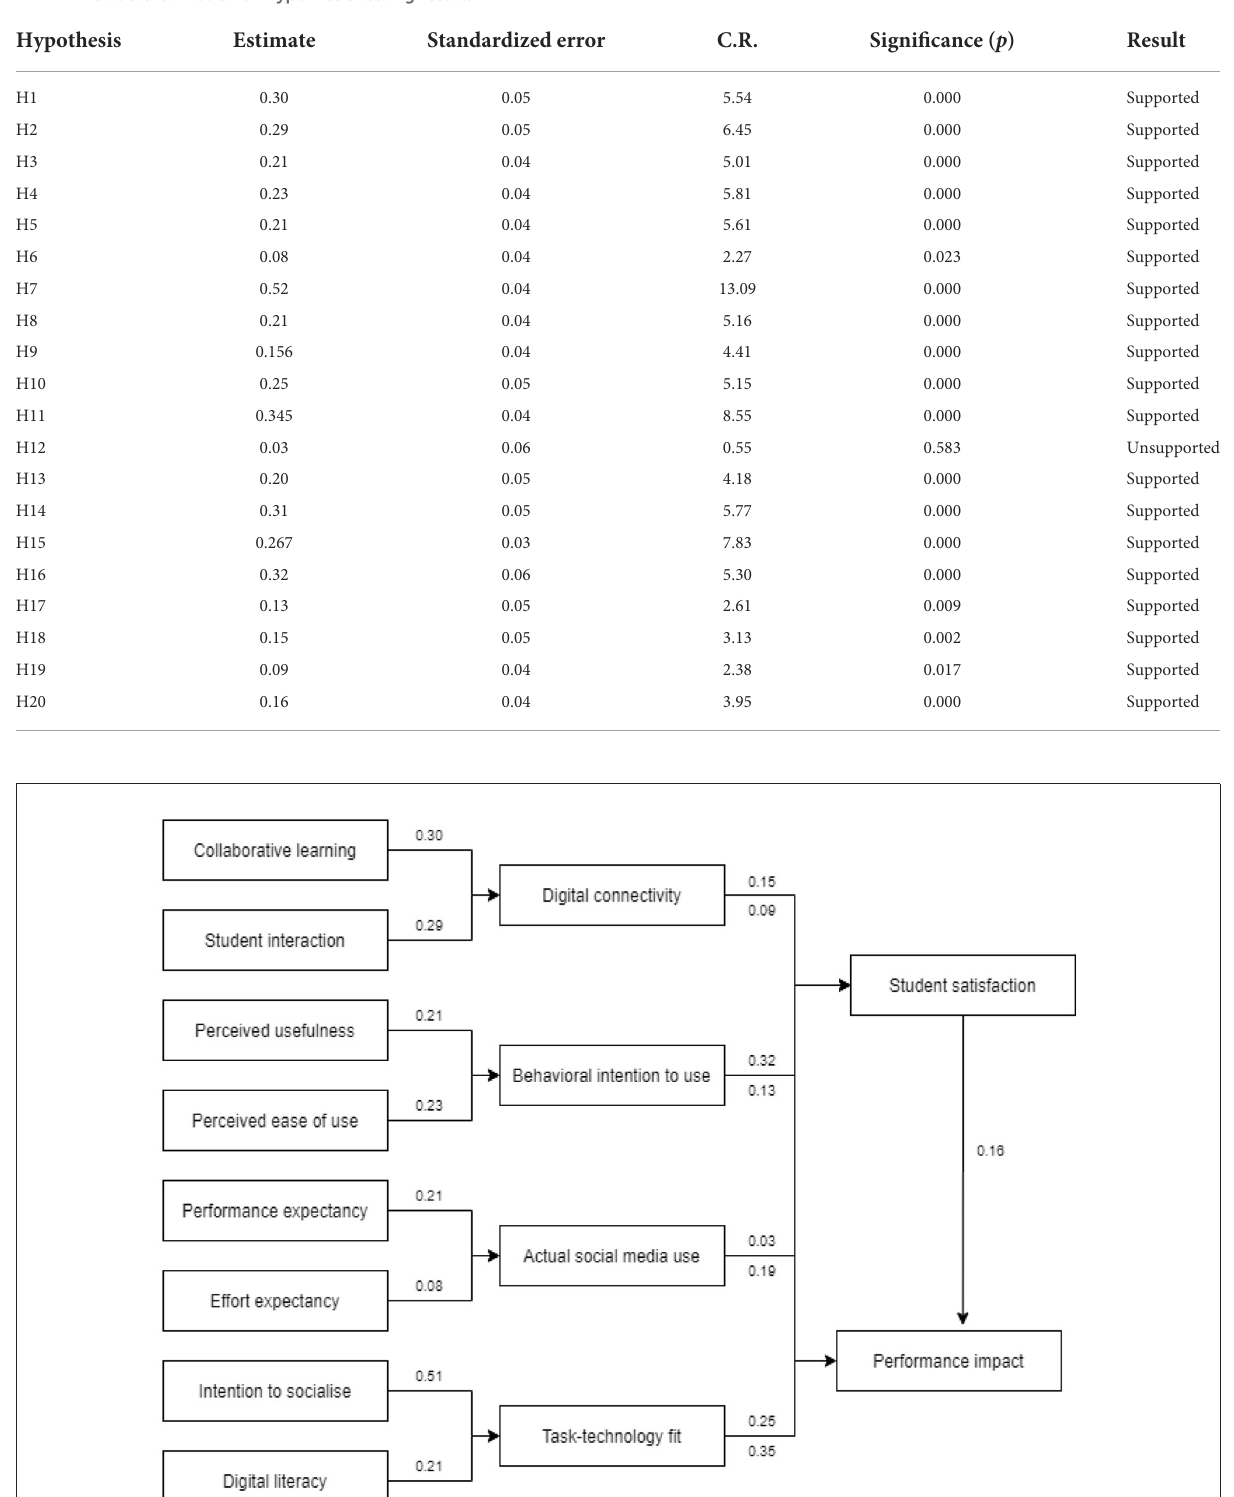
TABLE 4 Structural model for Hypothesis testing results.